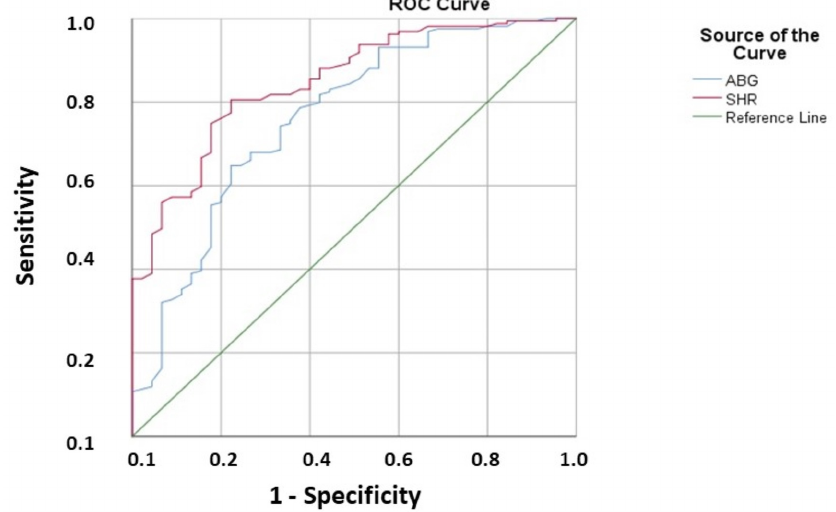
Figure 2. ROC (Receiver operation characteristic) curve and AUC (Area under the curve) for admis- sion blood glucose (ABG) level and stress hyperglycemia ratio for predicting postoperative acute kidney injury. (ABG: Cut-off: 265, AUC: 0.763, 95% CI: 0.680–0.846, p < 0.001, 78.4% sensitivity and 56.7% specificity, SHR: Cut-off: 1.89, AUC: 0.849, 95% CI: 0.790–0.908, p < 0.001, 86.4% sensitivity and 61.6% specificity).